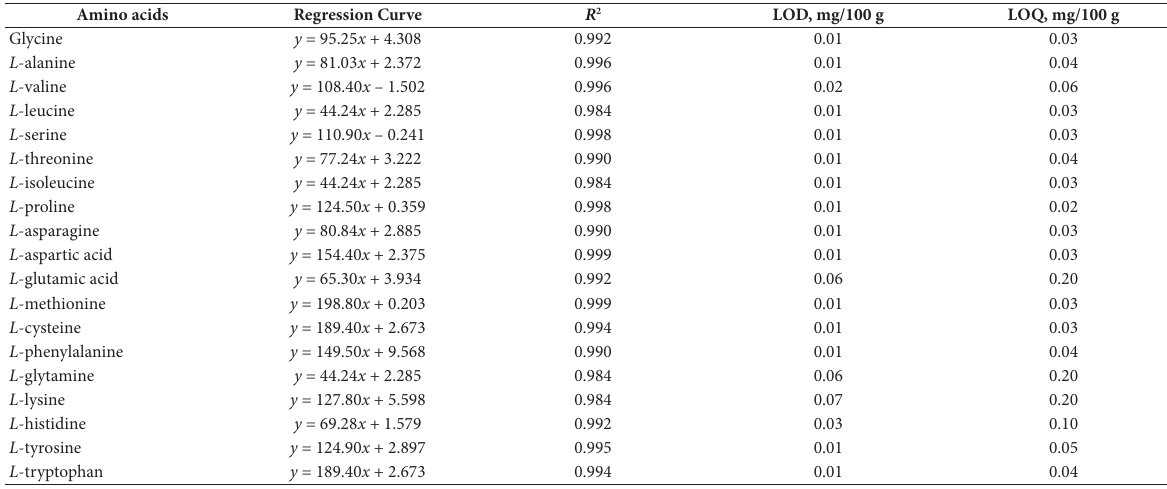
Table 4. Results of linearity data obtained for individual amino acids after GC-MS analysis. Amino